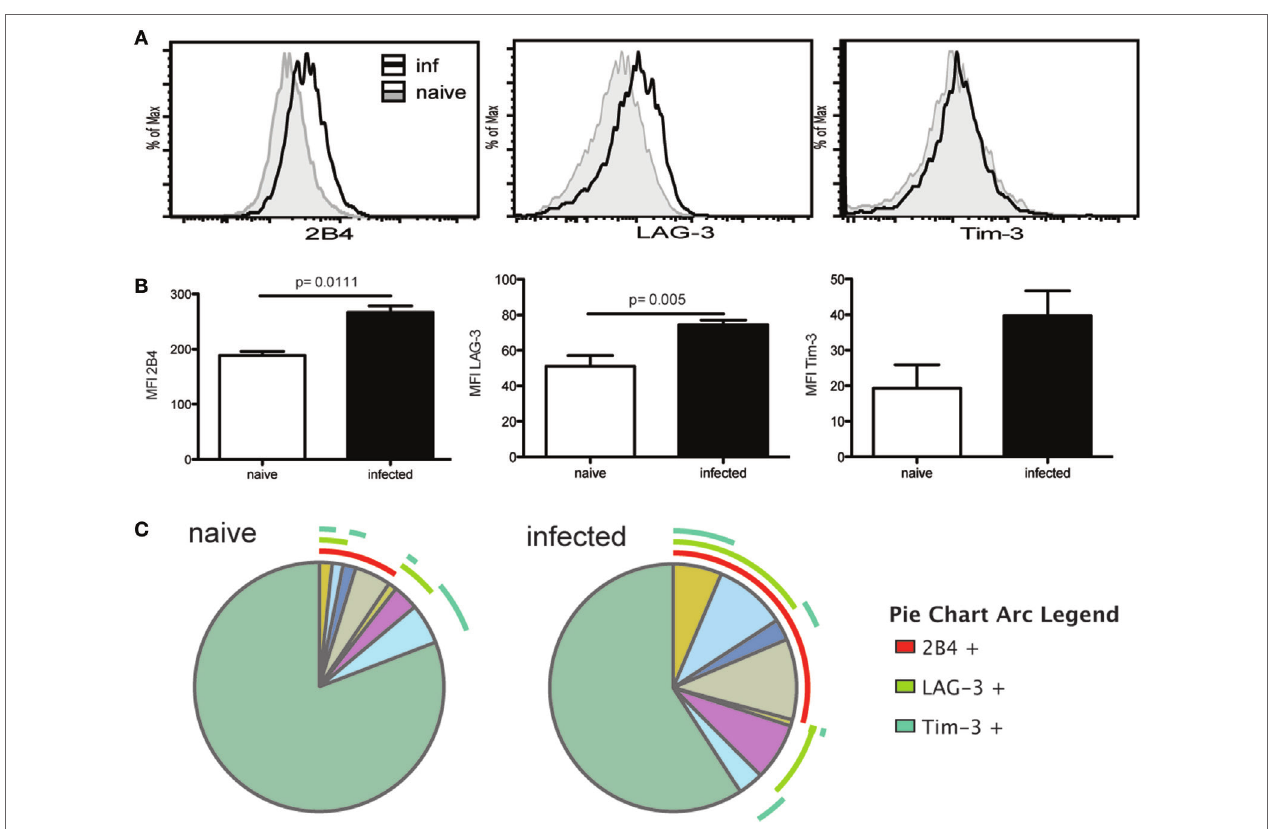
FigUre 2 | T follicular helper cells (Tfh) exhibit markers of exhaustion during the chronic phase of infection. Expression of exhaustion markers (2B4, Tim-3, and LAG-3) by antigen-specific Tfh at week 7 p.i. and Tfh from naïve animals was analyzed by flow cytometry. Graphs show the overlay of antigen-specific Tfh and Tfh from naïve animals for 2B4, LAG-3, and Tim-3 expression (a) . MFI for exhaustion markers is compared between Tfh from naïve controls and antigen- specific Tfh at week 7 p.i. (B) . SPICE analysis shows Tfh co-expression pattern for 2B4, LAG-3, and Tim-3 for antigen-specific Tfh at week 7 p.i. and Tfh from naïve mice (c) . Experiments were carried out at least twice and data are representative of one